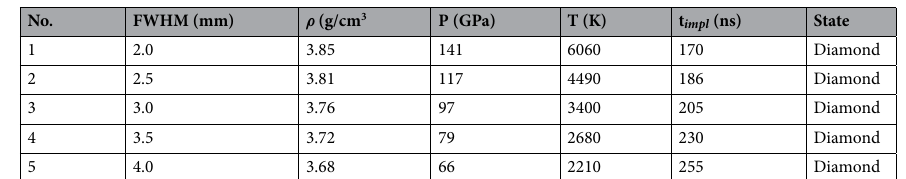
Table 7. Achieved physical conditions in compressed carbon using bunch intensity = 2 × 10 11 uranium ions, bunch length = 200 ns, particle energy = 2 GeV/u, initial sample radius, R si = 300 μm, sample mass = 6.4 mg/ cm.